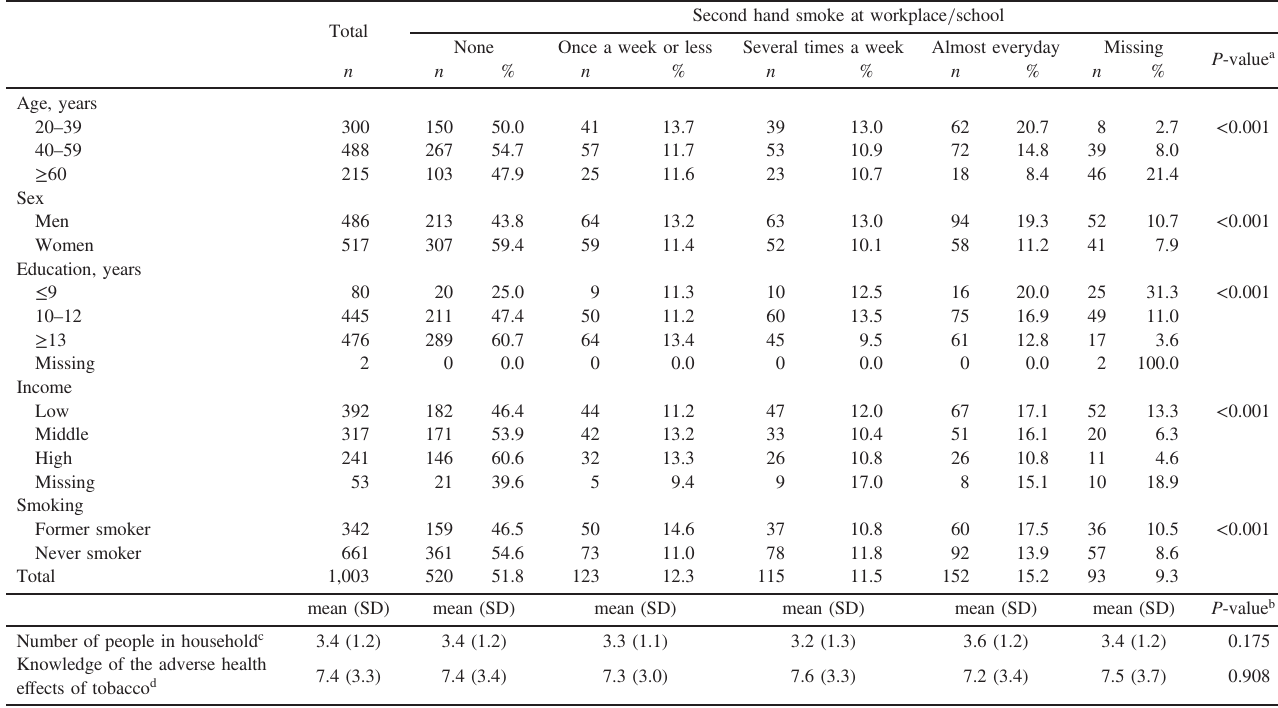
Table 2. Characteristics of the analytical participants for secondhand smoke at the workplace / school ( n = 1,003) Second hand smoke at workplace = school Total None Once a week or less Several times a week Almost everyday Age, years 20 – 39